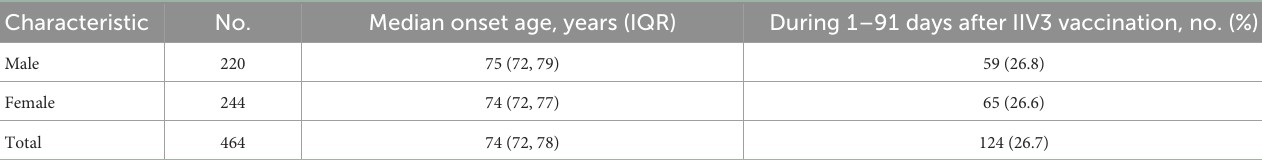
TABLE 1 Characteristics of the elderly with PFP in the study.